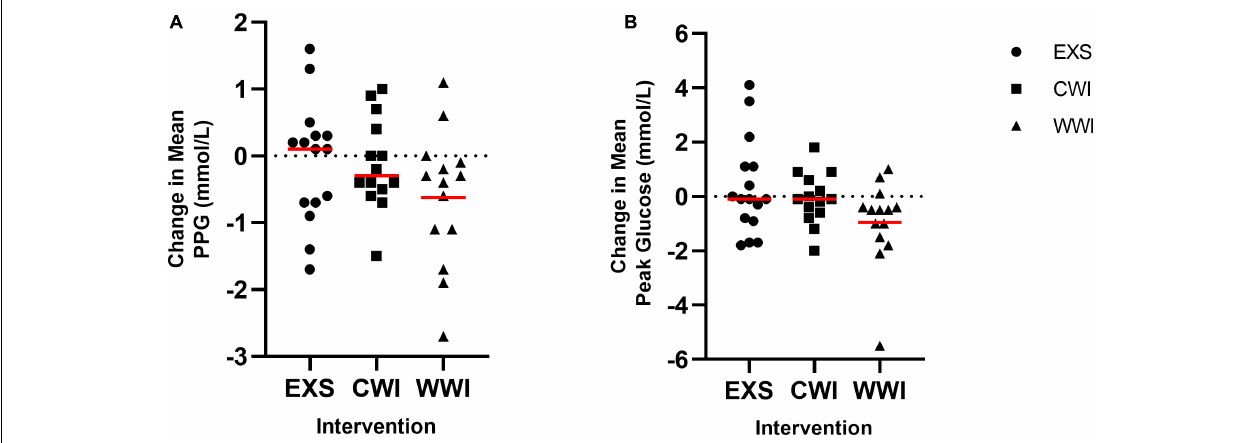
FIGURE 5 | (A) Change in post-prandial Glucose (PPG) after 12 sessions of time-matched exercise [EXS ( n = 15)], post-exercise Cold Water Immersion [CWI ( n = 14)] and post-exercise Warm Water Immersion [WWI ( n = 14)]. No significant interaction effect. (B) Change in Peak PPG after 12 sessions of EXS ( n = 16), CWI ( n = 14) and WWI ( n = 14). No significant interaction